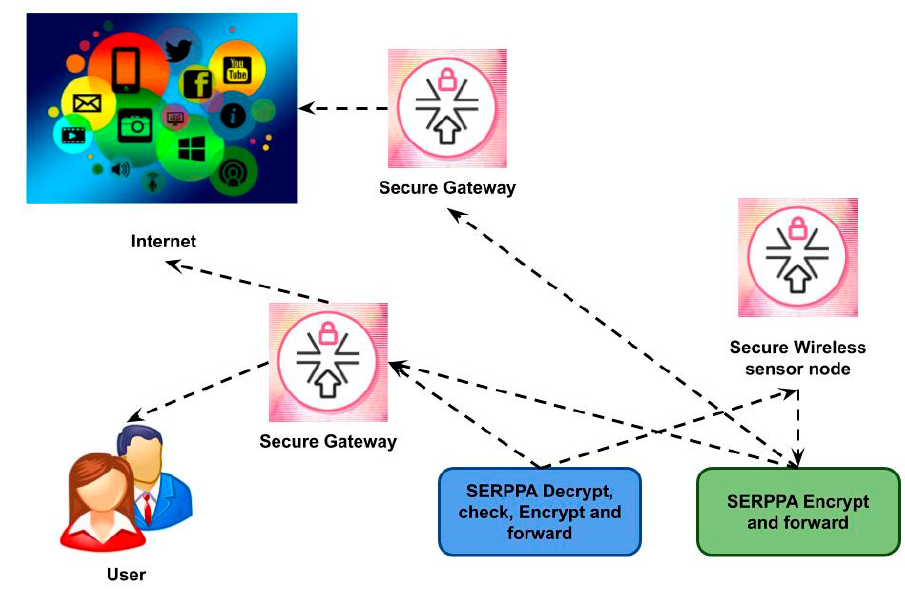
Figure 2. Architecture of SERPPA.